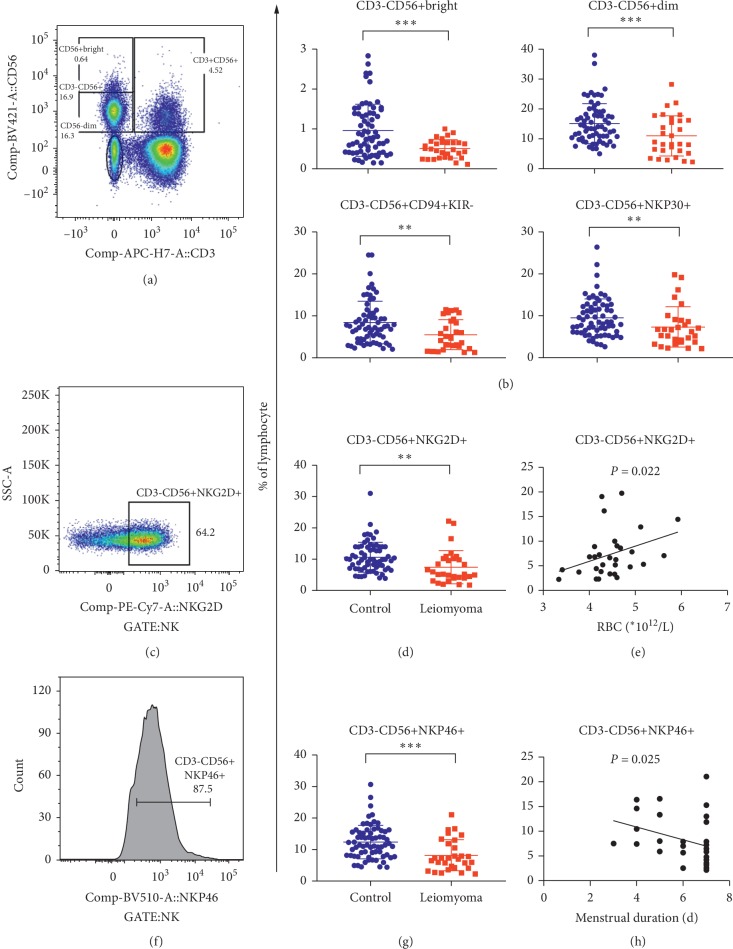
Distribution characteristics and significances of NK cells in 30 leiomyoma patients and 68 controls. (a, c, f) The flow analyses of the subgroups of the NK cells. (b, d, g) Comparison of the subgroups of the NK cells between patients and controls. (e) Correlation of CD56+NKG2D+ cells with red blood cells (RBC). (f) Correlation of CD56+NKP46+ cells with menstrual duration. ∗∗P < 0.01. ∗∗∗P < 0.001.